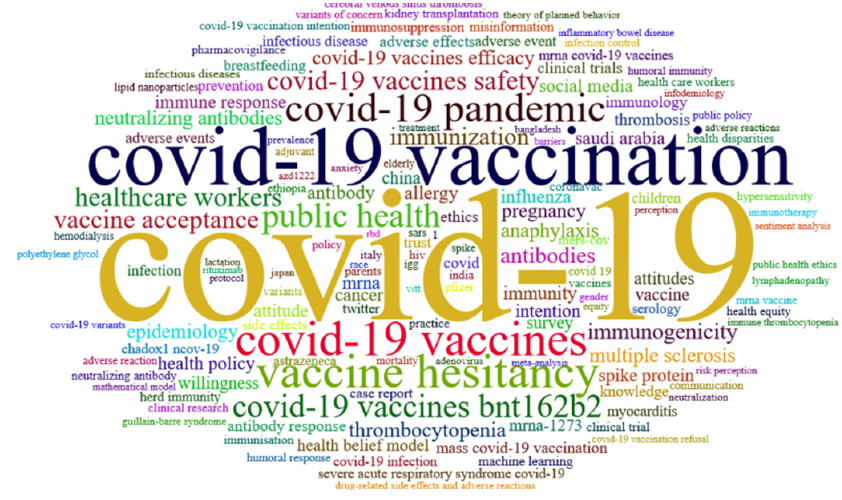
Figure 10. Word cloud map authors keywords in COVID-19 Vaccine research.